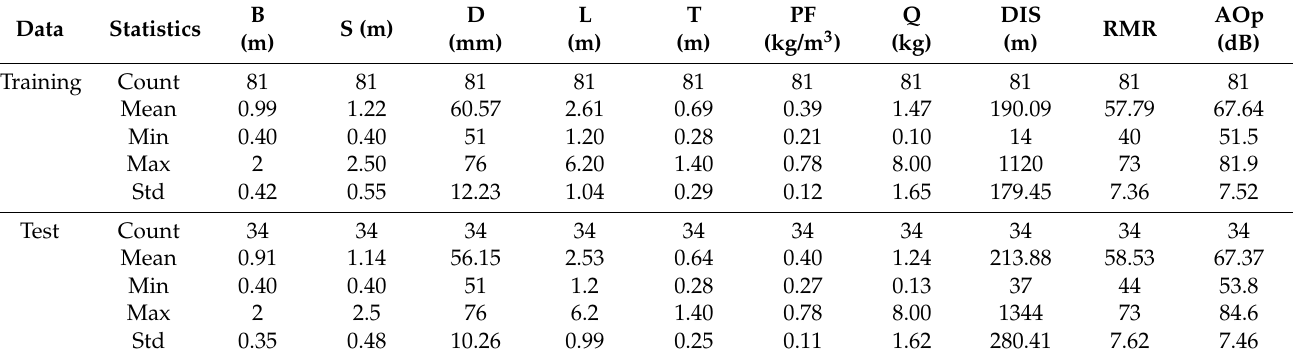
Table 1. Brief statistical description of AOp model training and test